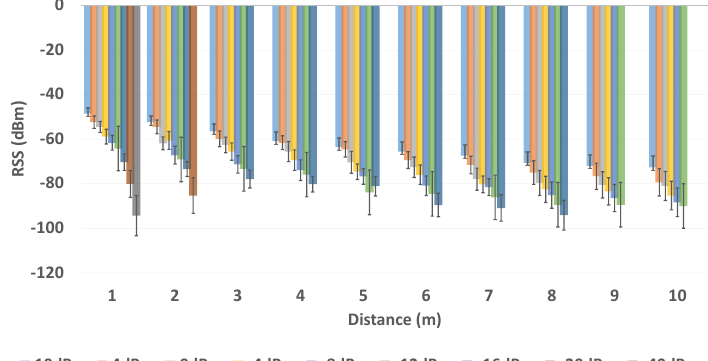
Figure 6. BLE RSS (dBm) with Multiple Transmission Power Level in Environment 1.